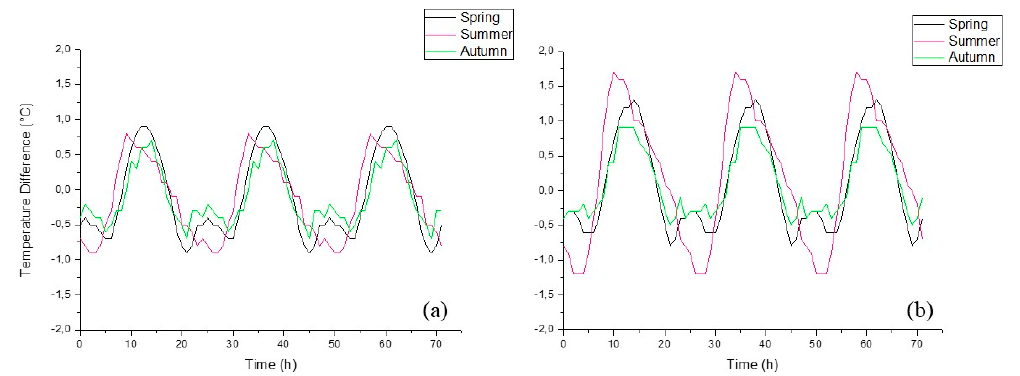
Figure 8. Thermal gradient between unmodified and PCM-based mortars: ( a ) hydraulic lime-based mortars and ( b ) cement-based mortars.